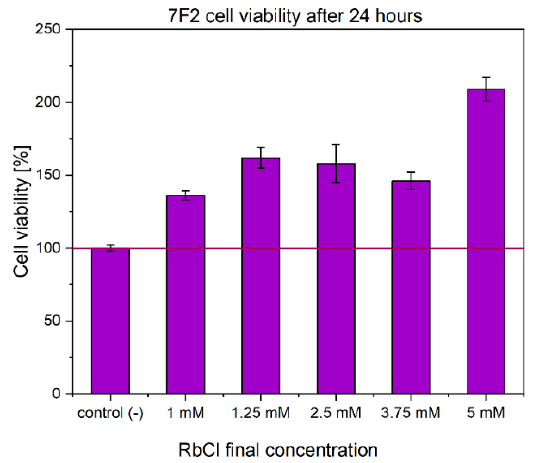
Figure 9. MTT cytotoxicity assay of RbCl towards mouse osteoblasts. Red bar marked as 100% of cell viability in the negative control probe. Cell morphology and the ratio of live and dead mouse osteoblasts cells were visual- ized after 24 h incubation with both series of obtained nanopowders having a final con- centration of 100 µg/mL (Figure 10). The results of this experiments agreed with the results obtained in the MTT viability assay and clearly showed that morphology and live/dead ratio of 7F2 cell line is the same as those of cells observed in the negative control (untreated cells). Therefore, captured images confirmed results of previously conducted viability as- say. Furthermore, unaltered spindle shape of cells and undisturbed cell membrane are comparable to those in the negative control. This indicates full cytocompatibility of syn- thesized nanopowders (Figure 10).